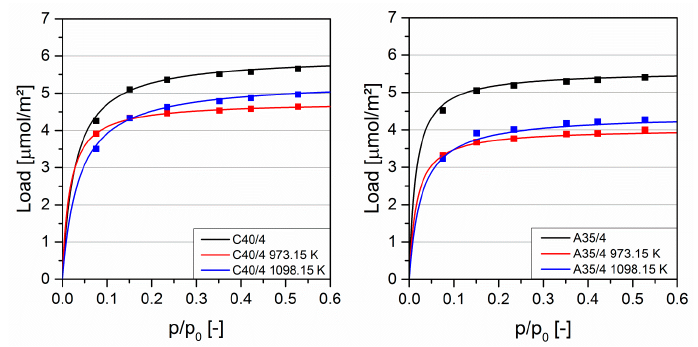
Figure 5. TGA adsorption measurements of toluene at 298.15 K (symbols: measuring data (Table S4), lines: fitted Langmuir isotherm (Table S2)). Table 2. Physico-chemical properties of activated carbons.